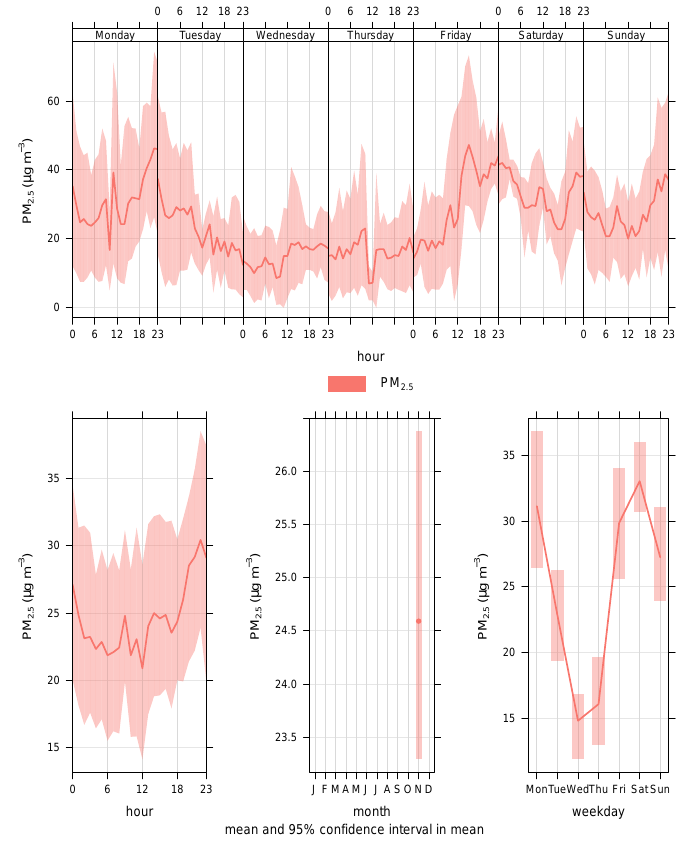
Figure 3. Hourly and daily PM2.5